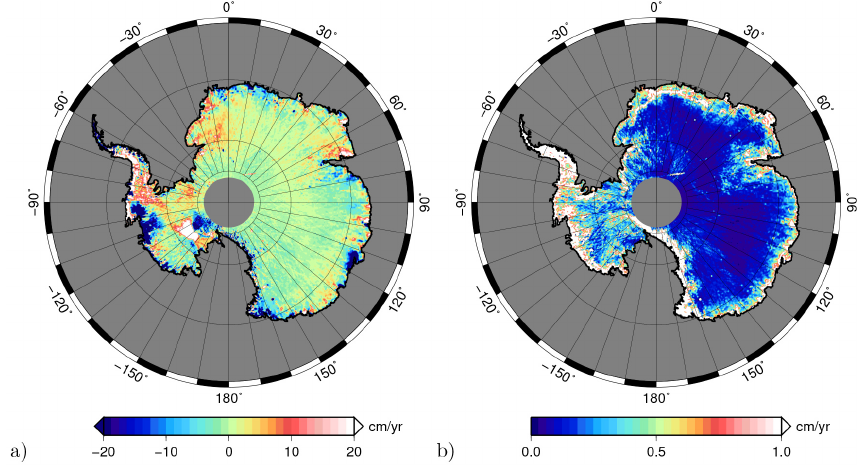
Fig. 3. (a) ICESat d h /d t estimates from the OFP approach and (b) corresponding uncertainties.